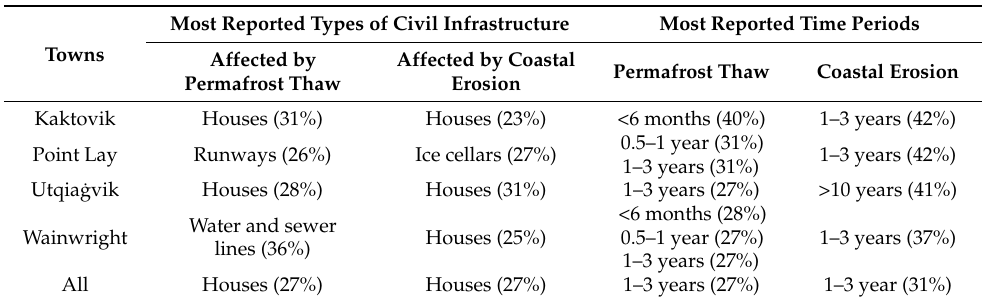
Table 4. Comparison of the most reported types of civil infrastructure affected by permafrost thaw and coastal erosion and their reported time periods.